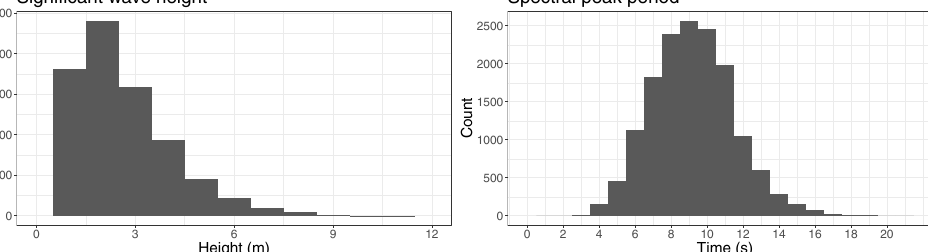
the lowest measurement at 50 % (see Fig. 7). In all cases of relative humidity below 55 % the air temperature was below freezing and in most cases winds were light. The mean rela- tive humidity was 87